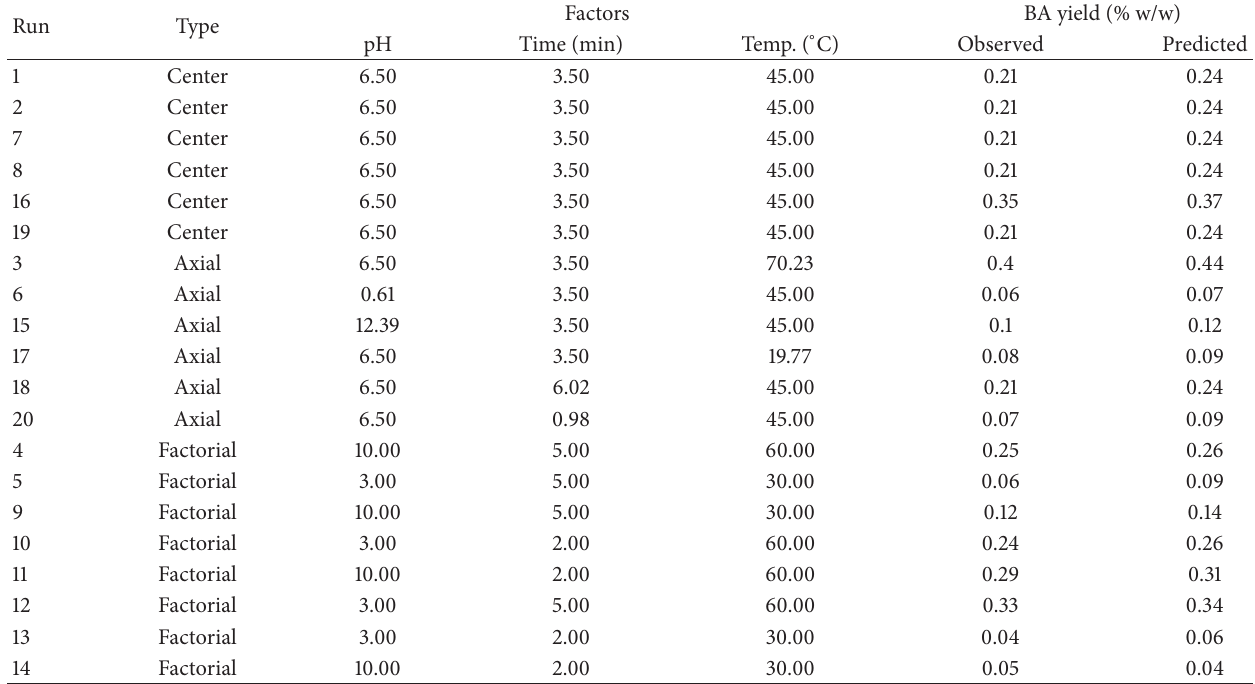
Table 2: Design matrix for the optimization of extraction parameters for maximum recovery of betulinic acid as response.